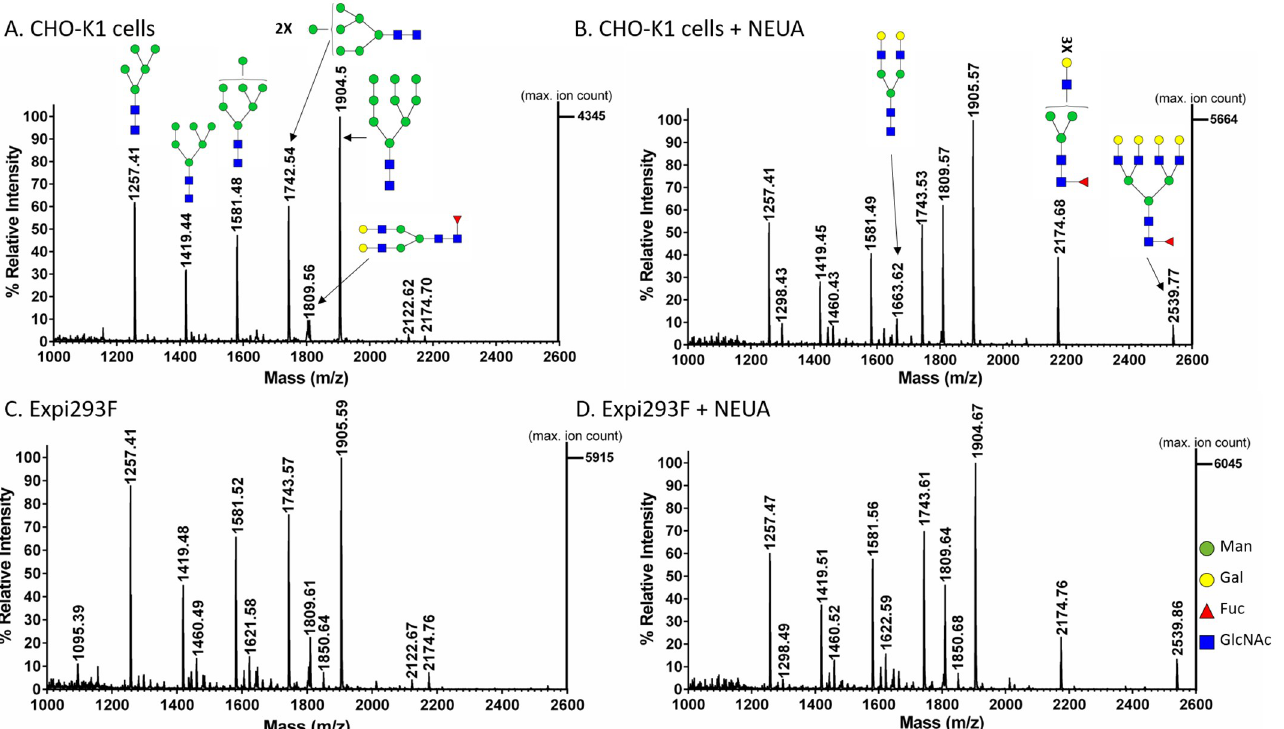
Fig 2. Positive ion MALDI-ToF analysis of N -glycans released from HIV-1 gp145. The recombinant gp145 (20 μ g) produced in ( A-B ) CHO-K1 and ( C-D ) Expi293F cells were incubated overnight with ( B and D ) and without ( A and C ) Neuraminidase A (NEUA) at 37˚C. Then, gp145 proteins were resolved by SDS-PAGE and the 145 kDa bands were excised. N -glycans were released with PNGase F and were co-crystallized with 2’,4’,6’-Trihydroxyacetophenone monohydrate (THAP) ionization matrix. The x-axis represents the mass-to charge ratio (m/z) value in Daltons and the y-axis shows the relative abundance (arbitrary units) of the ions. The released glycans were analyzed using the MALDI-ToF reflector positive mode. Predicted glycan structures of the masses shown in the upper panel spectrum are the same as those shown in the spectrum on the lower panel.